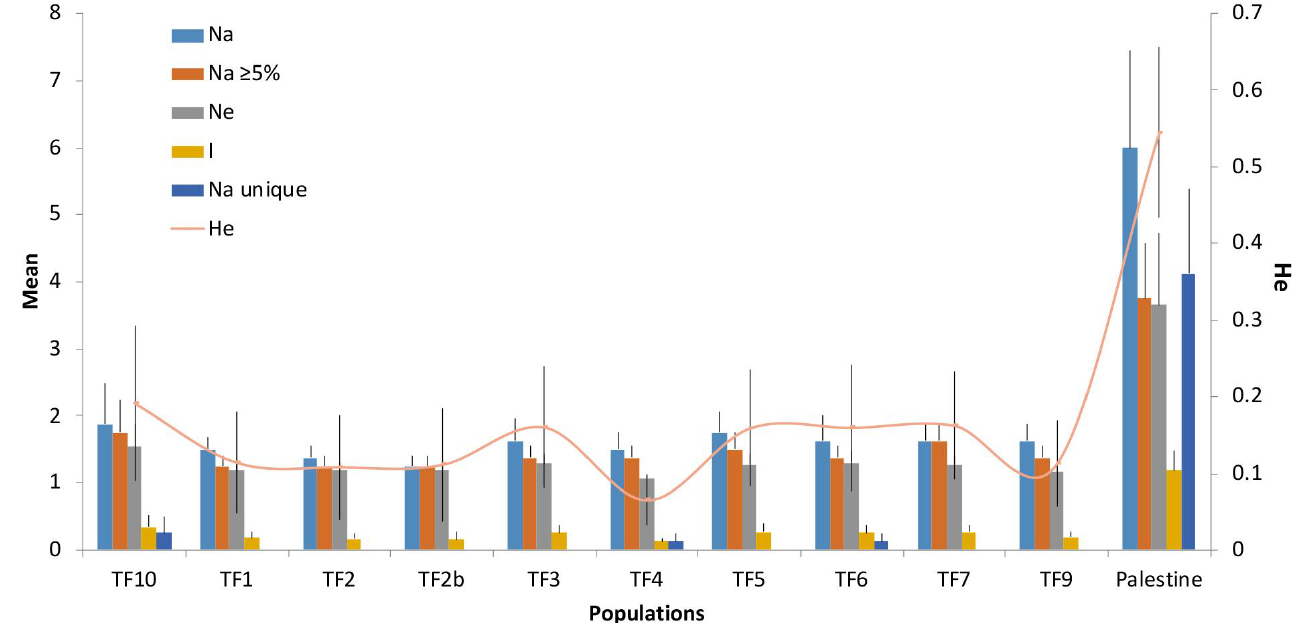
Figure 2. Genetic diversity parameters (mean over all loci) of the analyzed T. fragiferum populations. Na—number of alleles, Na ≥ 5%—number of alleles with a frequency equal to or more than 5%, Ne—effective number of alleles, I—information index, Na unique—number of unique alleles in each population, and He—expected heterozygosity.